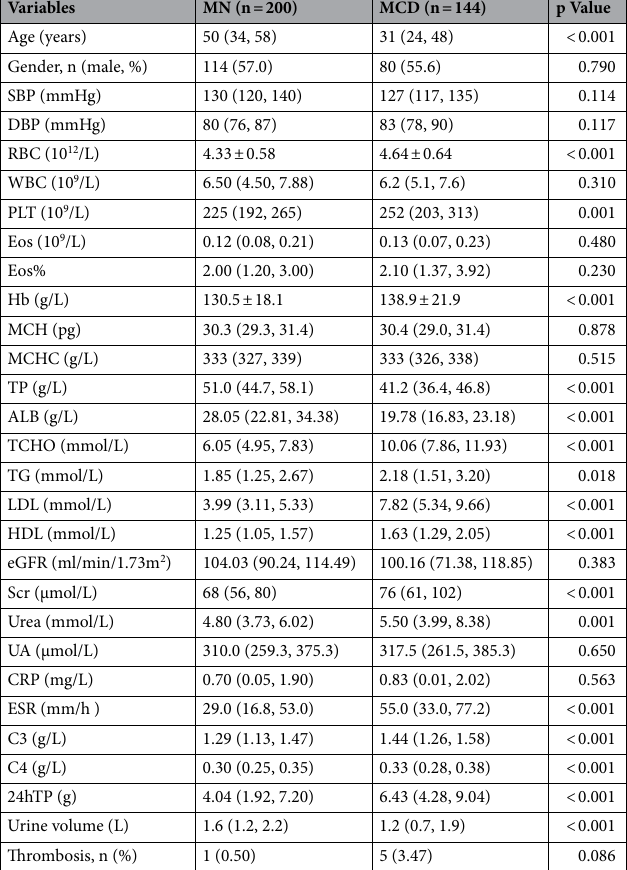
Table 1. Baseline characteristics of PLA2R-negative MN and MCD. SBP systolic blood pressure, DBP diastolic blood pressure, RBC red blood cell, WBC white blood cell, PLT platelet, EOS eosinophil, Hb hemoglobin, MCH mean corpuscular hemoglobin, MCHC mean corpuscular hemoglobin concentration, TP total protein, ALB albumin, TC total cholesterol, TG triglyceride, LDL low density lipoprotein, HDL high density lipoprotein, eGFR estimated glomerular filtration rate, Scr serum creatinine, UA uric acid, CRP C reactive protein, ESR erythrocyte sedimentation rate, C3 complement 3, C4 complement 4, 24hTP 24 h uric total protein, thrombosis venous thrombosis of lower